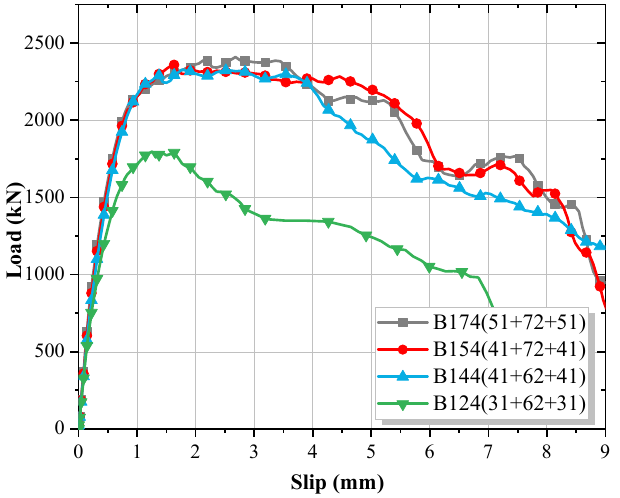
Figure 23. Load-slip curves of specimens with different stud horizontal spacing.